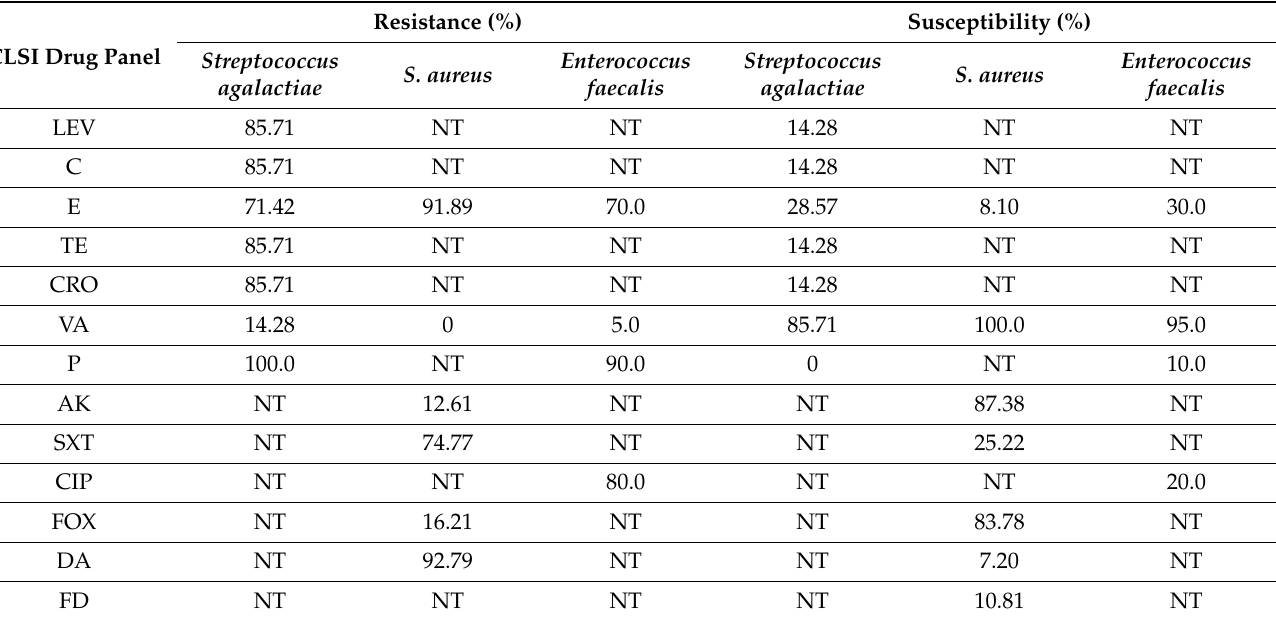
Table 3. The antibiotic susceptibility patterns of Strep. agalactiae , S. aureus, and Enterococcus faecalis with reference to CLSI